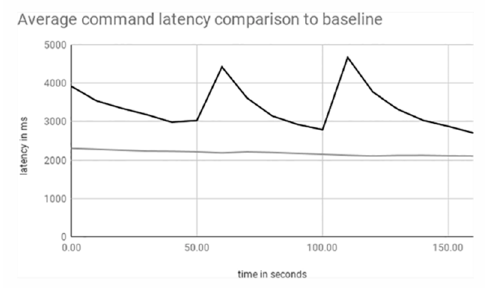
Figure 24. Average command latency of twice scaled cluster versus the baseline, single shard cluster.